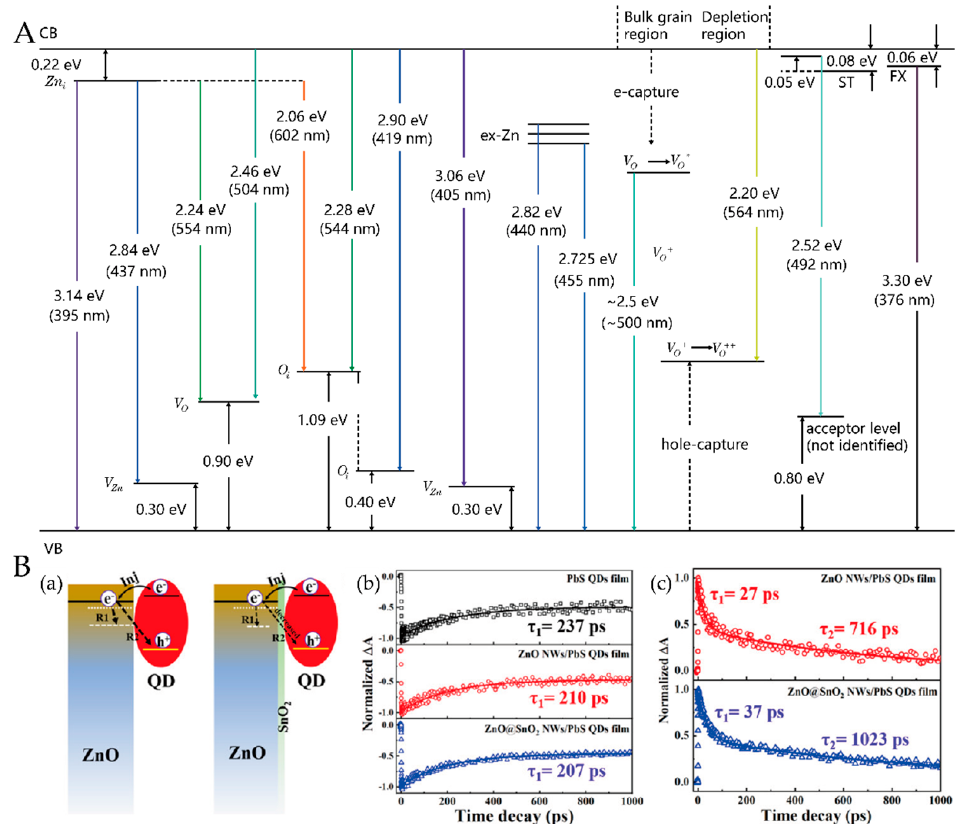
Figure 9. ( A ) Energy level diagram showing some of the principal defect levels in ZnO [101]; ( B ) ( a ) charge dynamic processes occurring at the ZnO NW/QD film interface. TA decay curves of the PbS QD film, ZnO NW/PbS QD film, and ZnO@SnO 2 NW/PbS QD film with a pump light of 470 nm and probe lights of ( b ) 960 and ( c ) 1500 nm [104]. Table 4. Performance optimization of IBHJ QDSCs with passivation strategies.